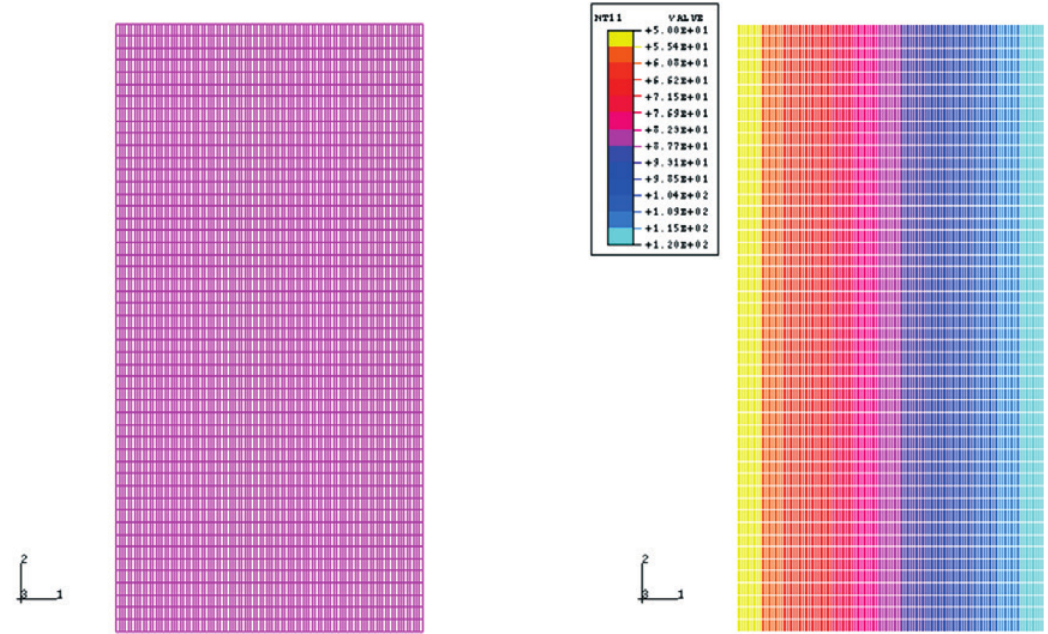
Finite element model (5151 nodes, 5000 elements) and temperature variation in the wave propagation